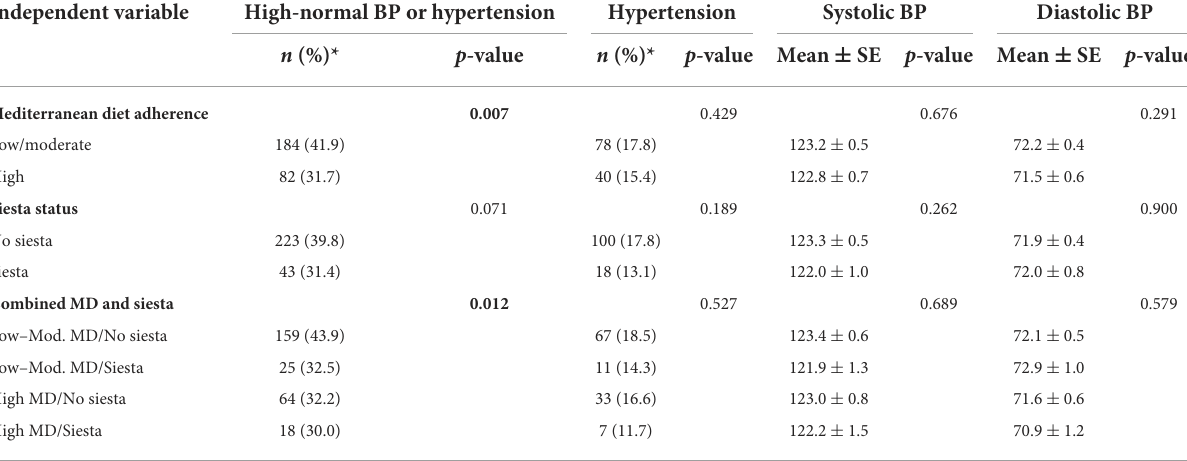
TABLE 2 Association of high-normal blood pressure or hypertension with adherence to the Mediterranean diet and siesta separately and in combination. Independent variable High-normal BP or